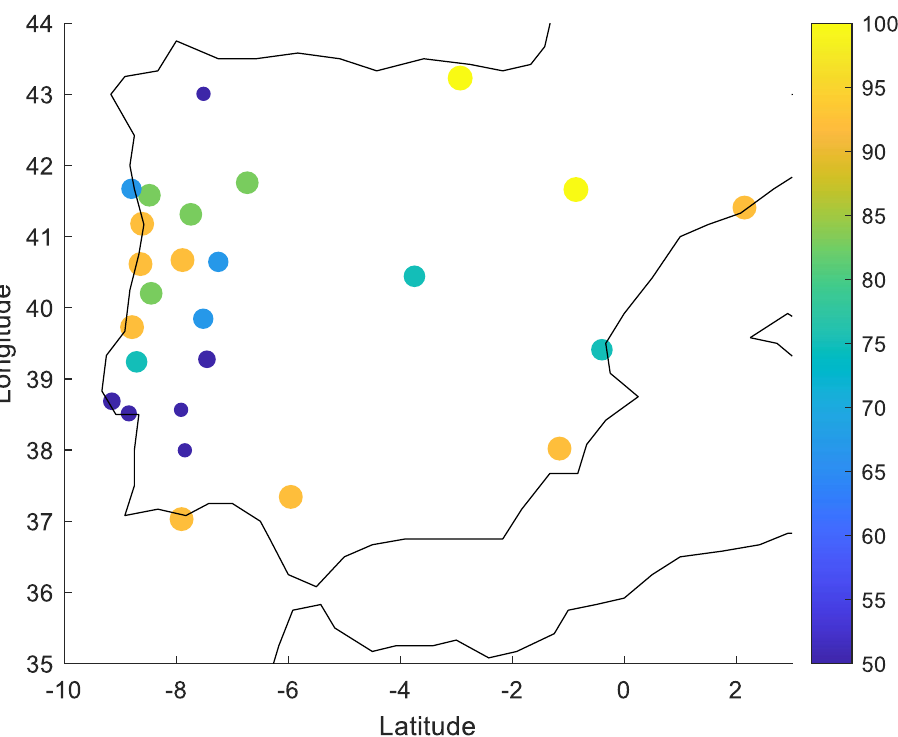
Figure 4. Average percentage of time in one year that near surface wind speed differences, future minus historic, are negative.